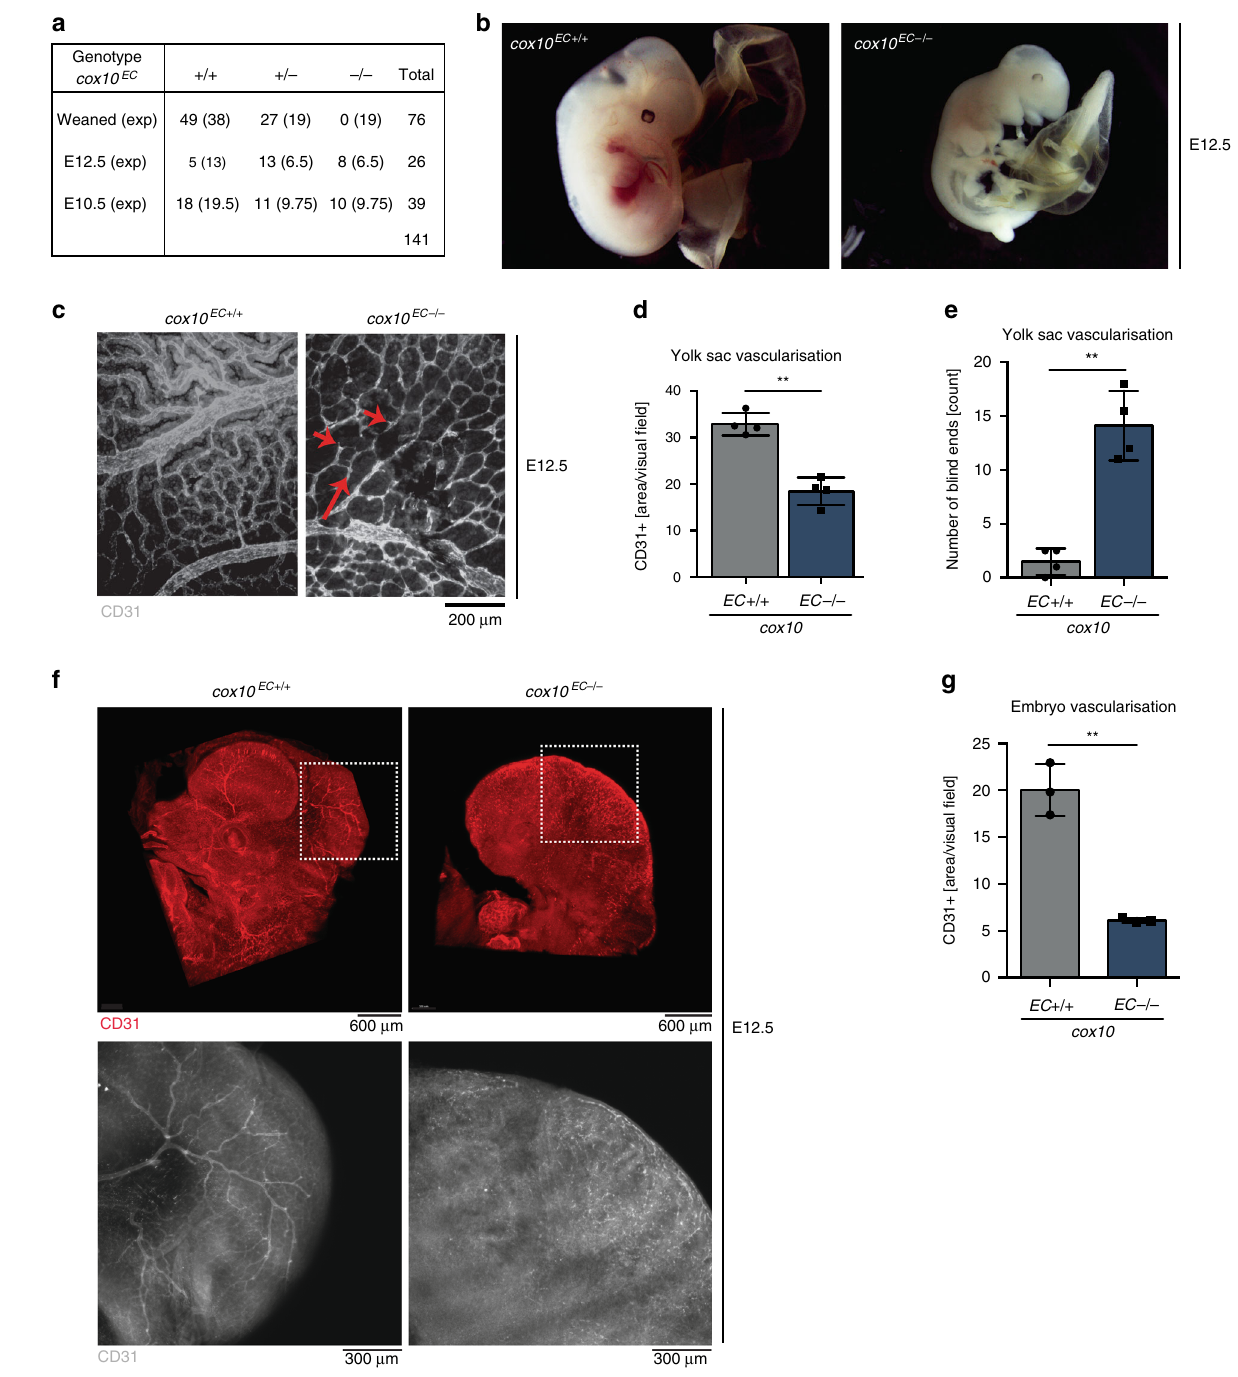
Fig. 1 Endothelial cox10 is required for embryonic development. a Genotypes of weaned mice or embryos at different stages of gestation obtained from crossing Tie2-Cre cox10 fl /wt to cox10 fl / fl . b Representative images of cox10 EC + / + ( cox10 fl / fl ) and cox10 EC − / − E12.5 embryos. c Whole-mount yolk sacs stained with anti-CD31 as an endothelial marker and d quanti fi cation of CD31 + yolk sac vasculature ( n = 4/genotype). e Quanti fi cation of blind ends ( n = 4/genotype). f Whole embryos (E12.5) stained with anti-CD31 in 5-fold (upper panel) and 10-fold (lower panel) magni fi cation. g Quanti fi cation of embryo CD31 area density ( n = 3/genotype). Data are presented as mean ± SD. Individual data points in ( d , e , g ) represent analysed mice per genotype ( d , e n = 4, g n = 3). Exact p -values (unpaired students t -test, two-tailed): d 0.0003, e 0.0003, g